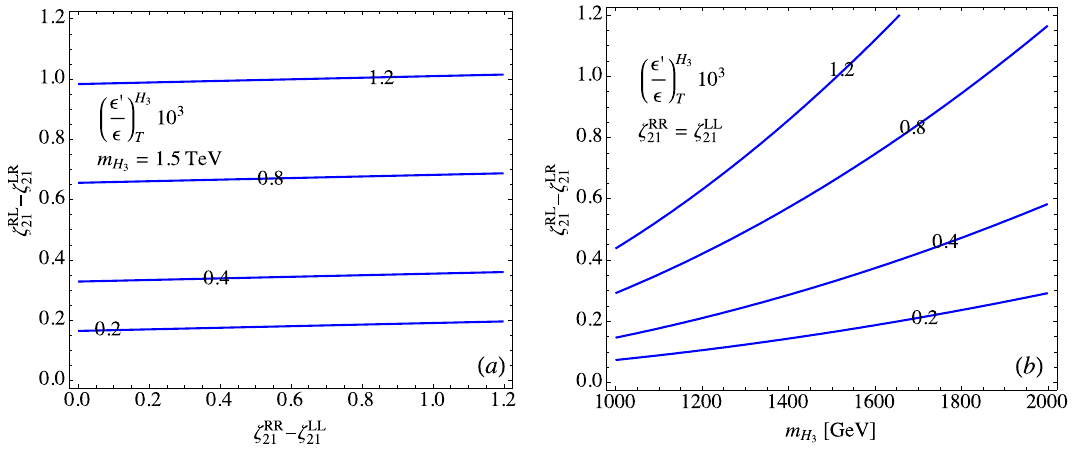
T (in units of 10 (cid:0) 3 ) as a function of (a) (cid:16) RR 0 =(cid:15) ) H 3 (cid:0) (cid:16) LR and (cid:16) RL , where m H = 1 : 5 TeV is used in plot (a), and we assume (cid:16) RR 21 21 3 3